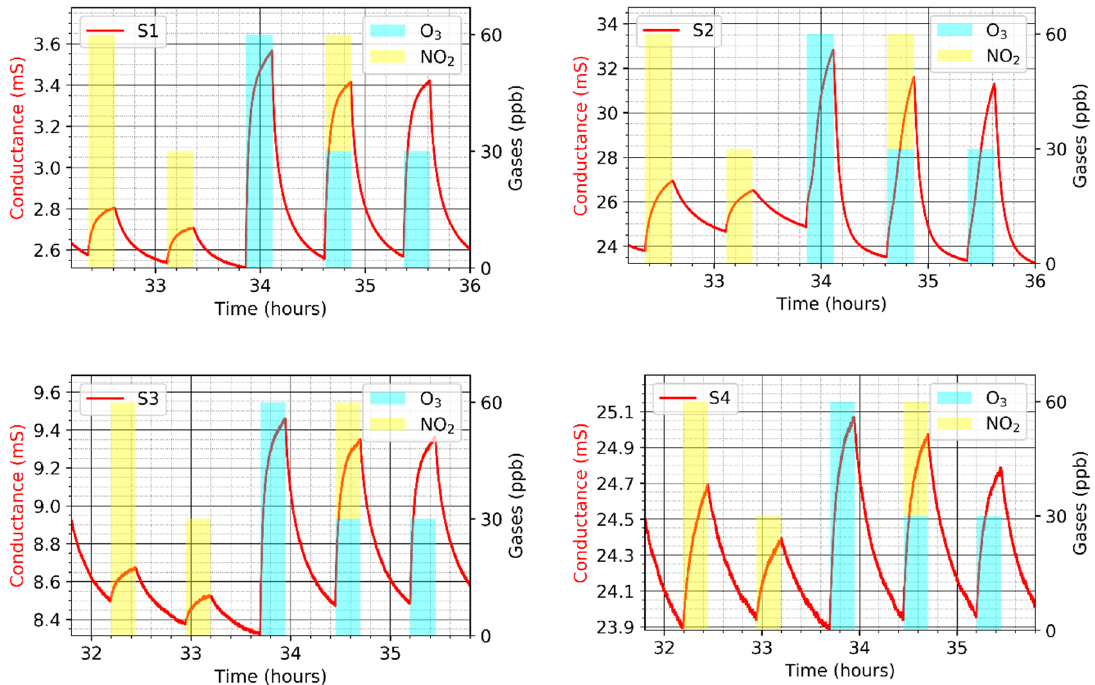
Figure 5. Extracts from the sensor responses (solid red lines, from Figure 5) as a function of gas composition, highlighted by yellow and blue bars for NO 2 and O 3 , respectively.